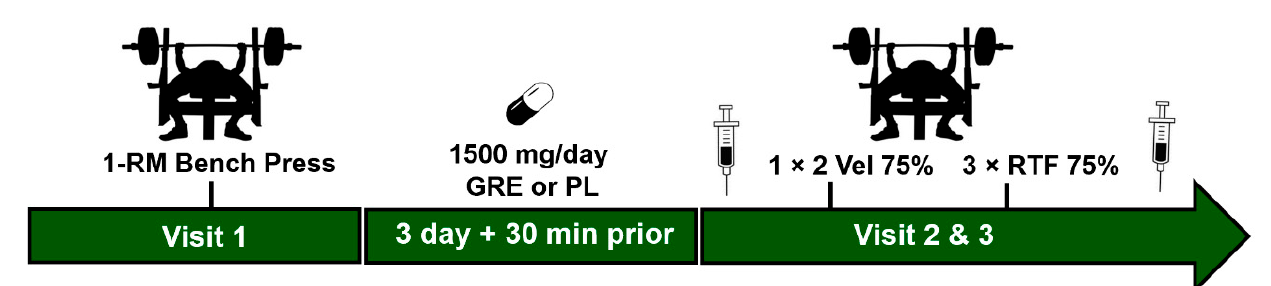
Figure 1. Study design. For the first visit, a one-repetition maximum (1-RM) for bench press was obtained for each participant. In a crossover counterbalanced manner, participants supplemented with GRE or Placebo (PL) for 3-days and took an additional dose 30 min prior to each visit. Blood (syringes) was collected before exercise (Pre) and after exercise (Post). For each visit, participants completed 1 set × 2 explosive reps at 75% of 1-RM to measure velocity (Vel). Following this, participants completed 3 sets × Repetitions to failure (RTF).